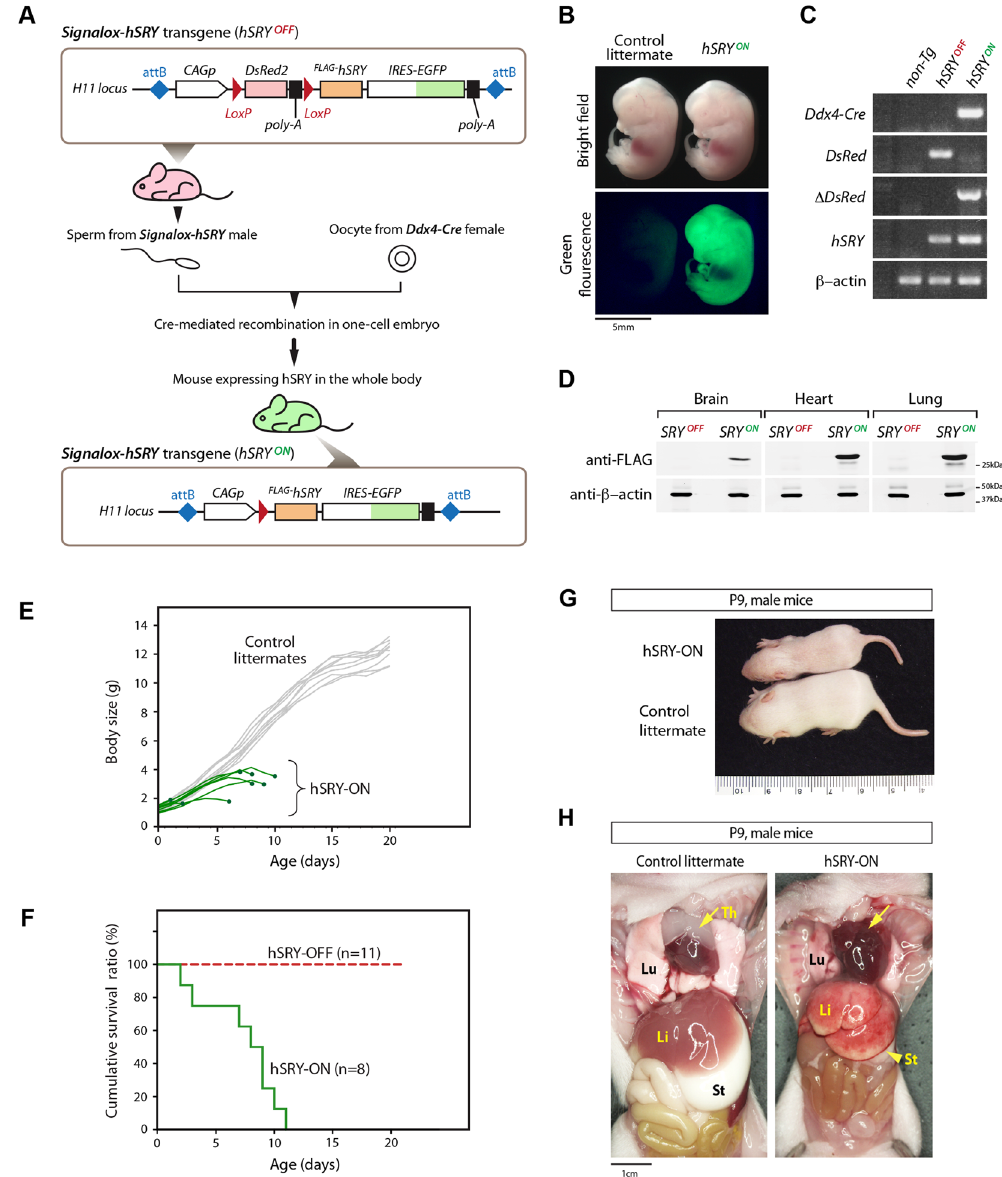
Figure 1. The Cre-LoxP transgene activation strategy for aberrant expression of the human SRY and growth retardation in transgenic mice. ( A ) Responder gene harboring human SRY-IRES-EGFP expression cassette (top box), capable of being activated with a Cre recombinase, i.e. from oocyte of female Ddx4-Cre transgenic mice (middle), resulting in activation of SRY-IRES-EGFP cassette (bottom box). ( B ) Co-expression of the EGFP gene in a E12.5 hSRY-ON embryo. ( C ) PCR analysis of non-transgenic, non-recombined and recombined Signalox- hSRY , showing reposition of SRY-IRES-EGFP under the CAG promoter. ( D ) Western blot analysis of protein lysates of brain, heart and lung from newborn, showing the absence and presence of FLAF-tagged human SRY protein in SRY OFF and SRY ON pups respectively. ( E ) Changes in body size of hSRY-ON and control littermates with age (in days). ( F ) Survival of hSRY-OFF and hSRY-ON pups with age (in days). ( G ) Example of the size of hSRY-ON and hSRY-OFF pups at P9 age. ( H ) Necropsy at P9 stage, showing lack of milk in the stomach (St) and digestive tract, absence of the thymus (Th, yellow arrows), and discolored lung (Lu) and liver (Li) in hSRY-ON animal (right), as compared to the control littermate